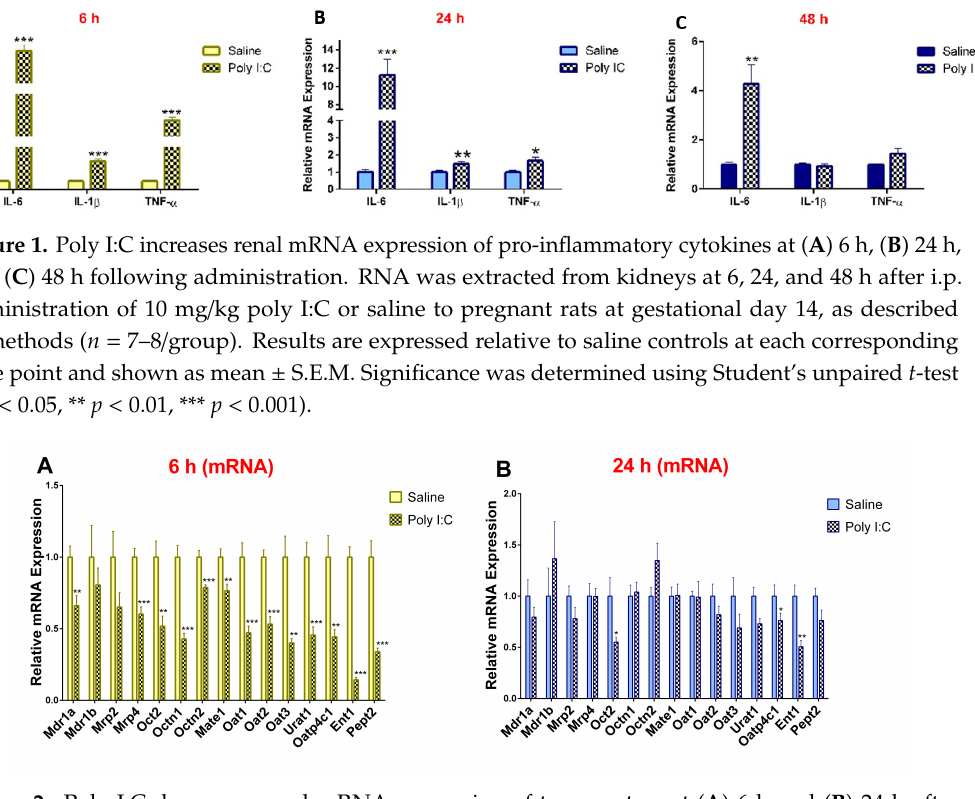
Figure 2. Poly I:C decreases renal mRNA expression of transporters at ( A ) 6 h and ( B ) 24 h after administration. RNA was extracted from kidneys at 6 and 24 h after i.p. administration of 10 mg / kg poly I:C or saline to pregnant rats at gestational day 14 as described in methods ( n = 7–8 / group). Results are expressed relative to saline control as mean ± S.E.M. Significance was determined using Student’s unpaired t -test (* p < 0.05, ** p < 0.01, *** p < 0.001).